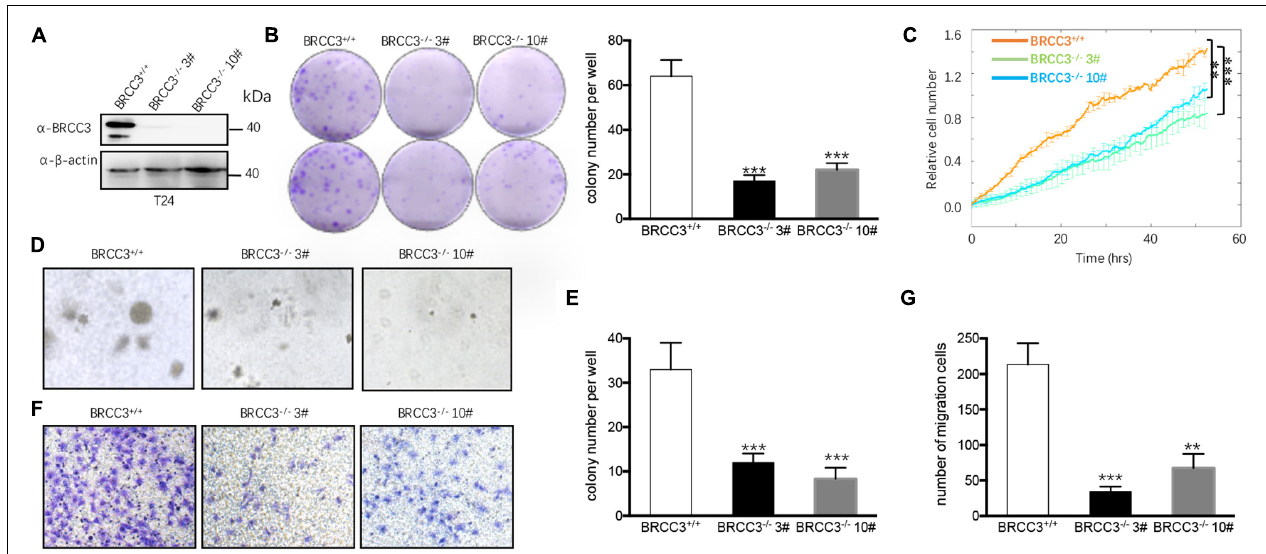
FIGURE 3 | The depletion of BRCC3 repressed tumor formation in vitro . (A) BRCC3-deficient cells were identified via Western blotting assays. (B) Colony formation assays. (C) An ECIS cell proliferation assay was performed. (D) Three-dimensional colony formation assay was performed in soft agar. The colony numbers are expressed as the means ± standard error of triplicate assays. (E) The Quantitative data show the colonies numbers in (D) . (F) Transwell migration assay. The relative cell numbers of migrating were statistically analyzed. (G) Quantitative data show the number of migrating cells in (F) . * P < 0.05, ** P < 0.001, and *** P < 0.001 compared with